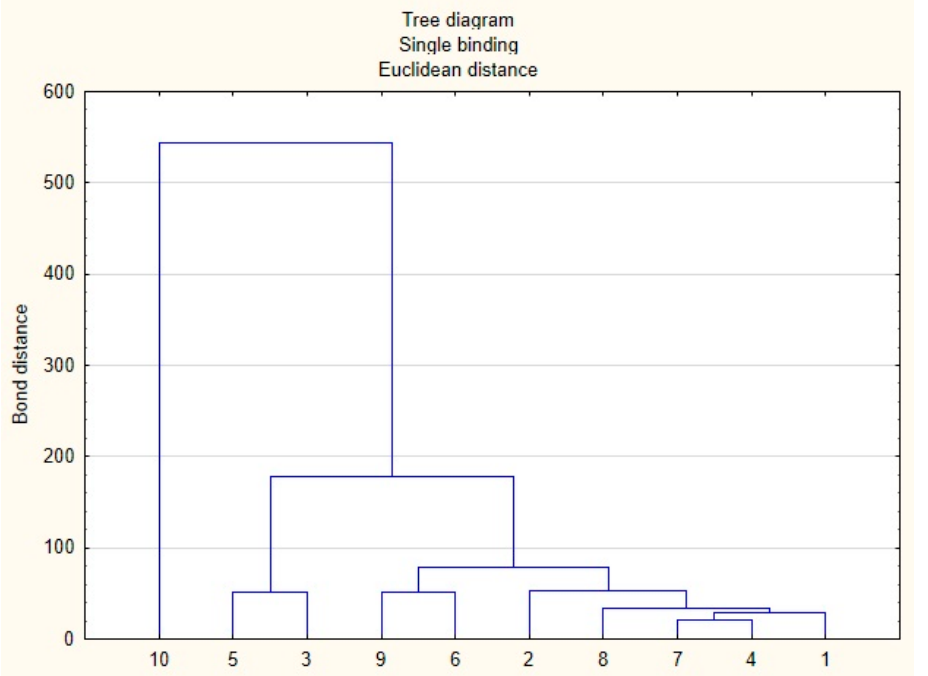
Figure 6. Tree diagram based on the average values of tested parameters for goldenrod honey samples (1–10).